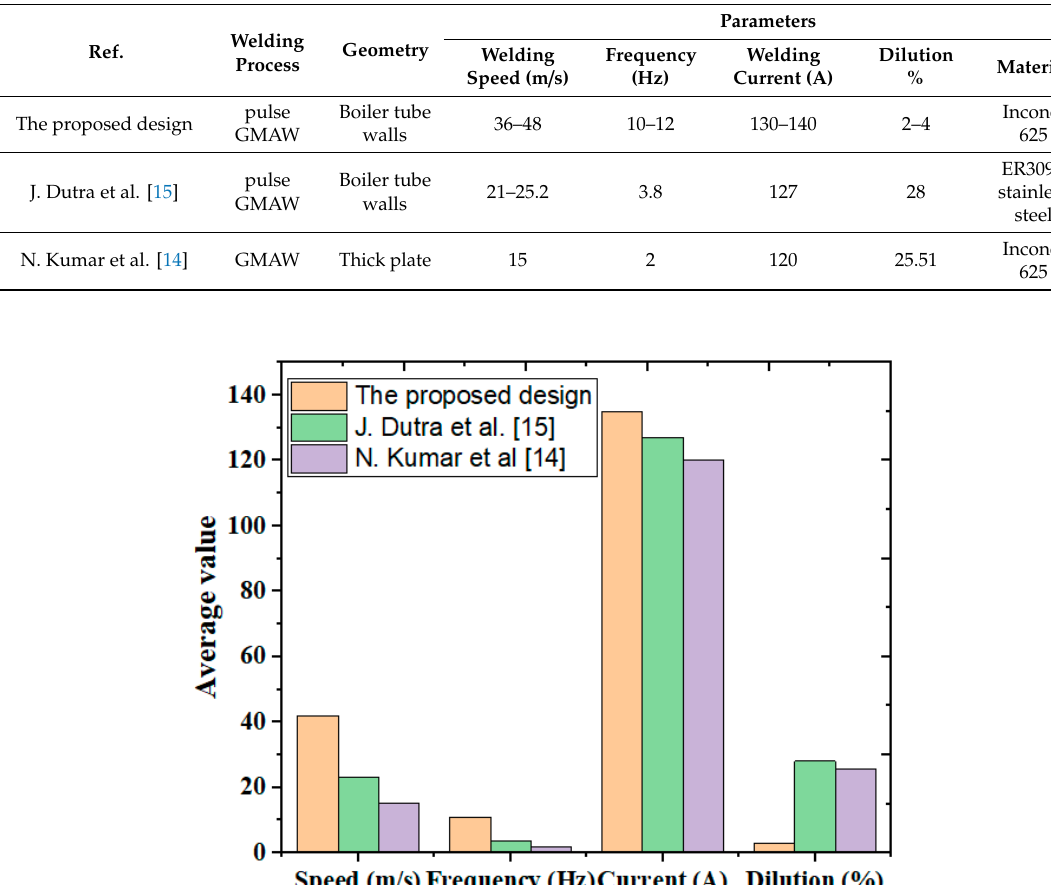
Table 5. A comparison of the proposed design with some previously published work.